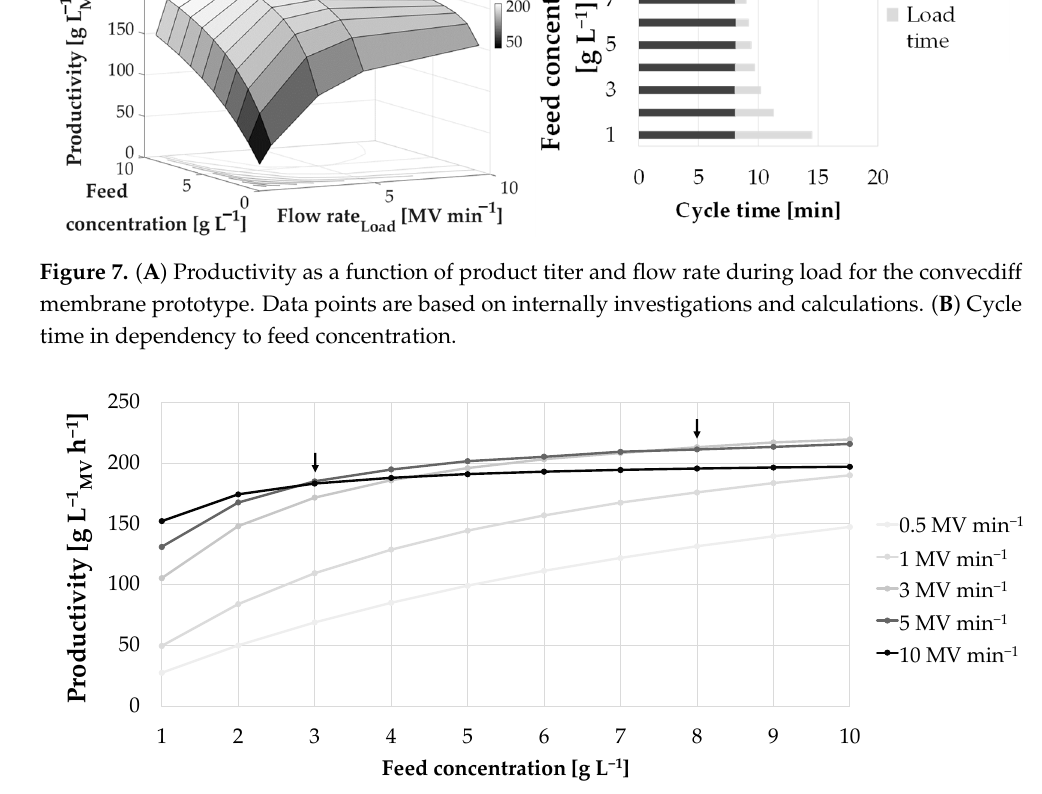
Figure 8. Productivity as a function of feed concentration at different flow rates during the load phase.